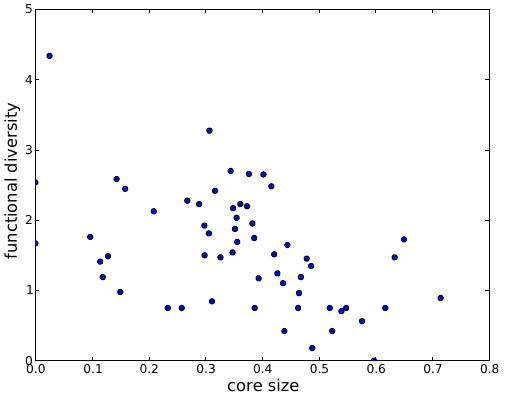
Figure 6: Scatter showing core size of superfamily against functional diversity (depth weighting of